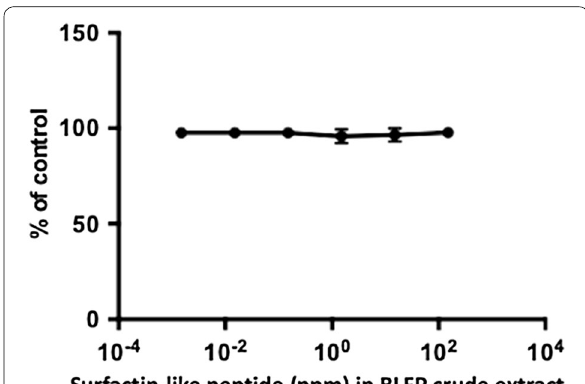
Fig. 5 The 50% cytotoxicity concentration of crude extract derived from Bacillus licheniformis (BLFP) in Vero cells. Different concentrations of BLFP crude extract were added to Vero cells and incubated for 48 h. BLFP crude extract showed no cytotoxicity to Vero cells when evaluated using the AlamarBlue ™ assay. Data are presented as the mean SD out of three test replicates ±